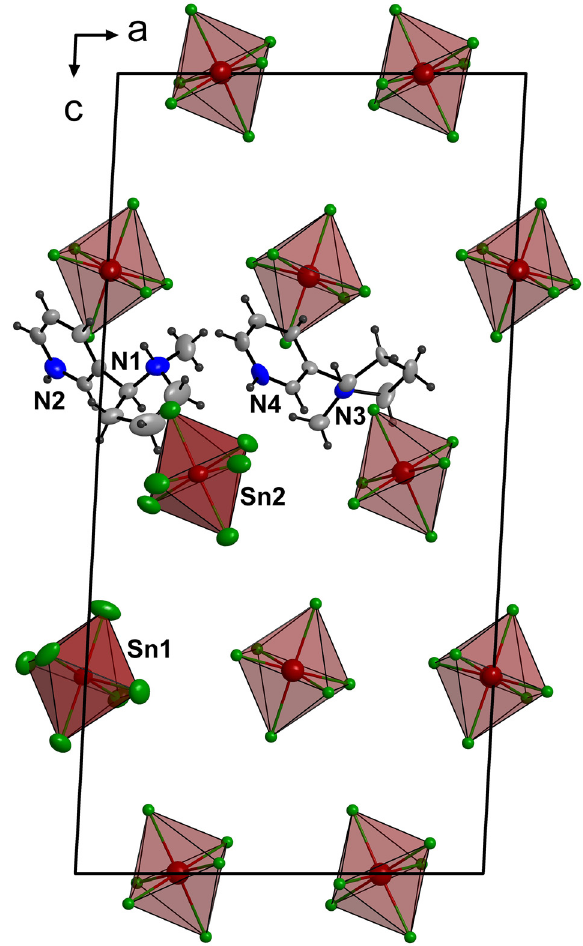
Table  : Data collection and